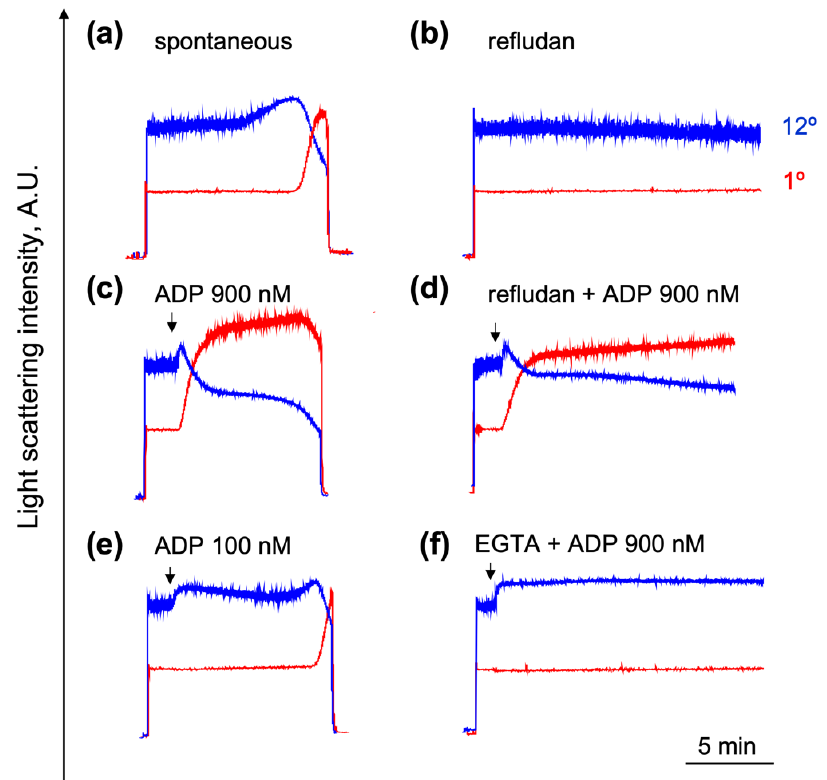
Figure 2. Characterization of the clot formation reaction by the laser diffraction method. PRP diluted in the HEPES buffer (1 × 10 7 platelets/mL) was added to the cuvette with a continuous stirring (1200 rpm) at 25 °C. The clot formation reaction was characterized as a returning of LSI at both angles to the background level. ( a ) Spontaneous clot formation accompanied by a slowly developing (slow increase in LSI at 12°) shape change reaction; ( b ) Refludan (20 µg/mL) completely prevented the reaction of clot formation; ( c ) platelet activation by ADP (900 nM) slightly accelerated clot formation reaction; ( d ) Refludan inhibited clot formation but had no effect on the shape change reaction and aggregation; ( e ) induction of the shape change reaction only by low (100 nM) ADP had no significant effect on the time of clot formation; ( f ) clot formation and aggregation, but not the shape change, induced by ADP (900 nM), were inhibited in calcium-free (2 mM EGTA) media. Presented are the original traces out of four independent experiments.